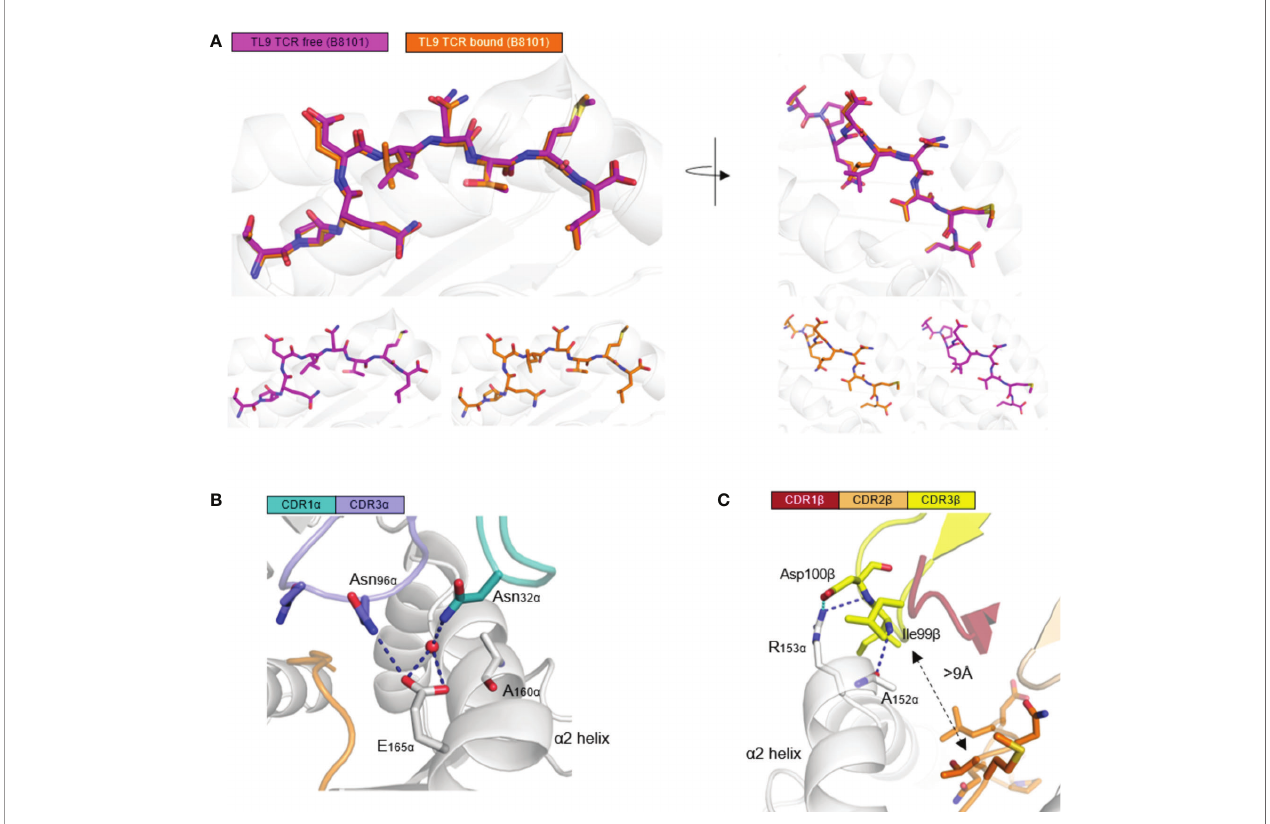
FIGURE 2 | HLA-B*81:01/TL9 complex binds to T18A TCR with no conformational change. (A) the conformational change of HLA-B*81:01/TL9 complex after T18A TCR engagement. (B, C) the interactions between T18A TCR and HLA-B*81:01/TL9 complex. TPQDLNTML peptide presented by HLA-B*81:01 (PDB: 4U1I) in peptide-MHC